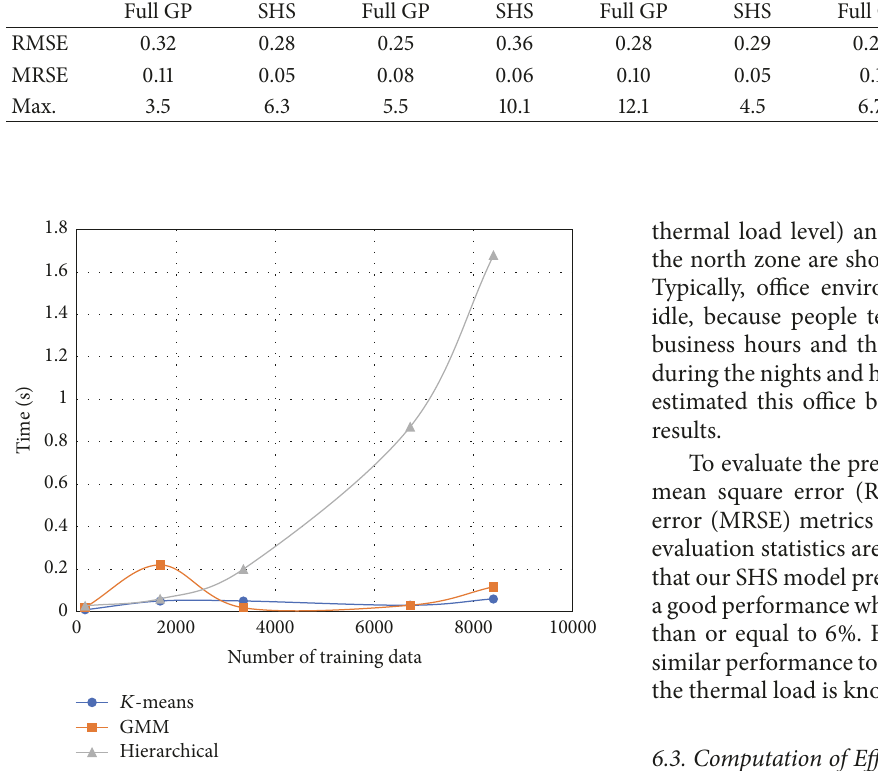
Figure 11: Clustering time for different data sizes of 𝐾 -means algorithm, GMM algorithm, and hierarchical clustering